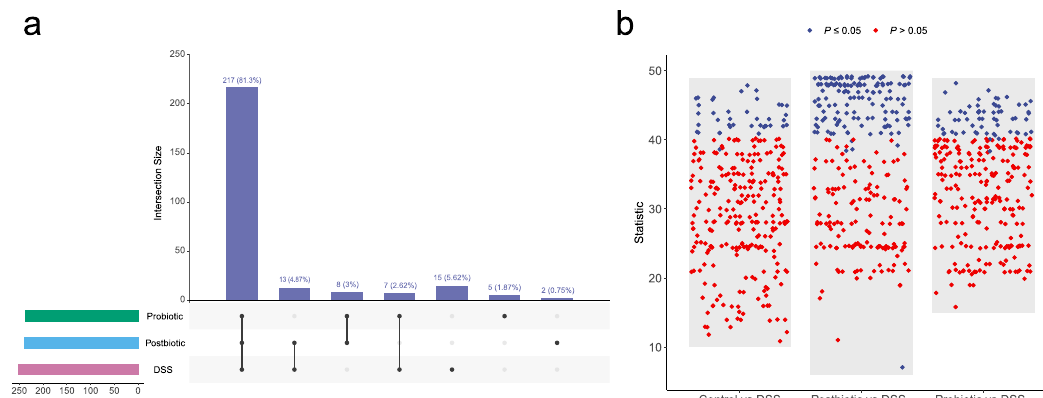
Fig. 5 Postbiotic and probiotic supplementation modulated the functional potential of the gut microbiome. a Number of metabolic pathways identi fi ed in the fecal metagenome of the Postbiotic, Probiotic, and Dextran sulfate sodium (DSS) groups (left panel). The right panel shows common pathways between datasets. b Number of differential metabolic pathways between groups: Control, Postbiotic, Probiotic groups versus DSS group. Differential metabolic pathways were detected by Wilcoxon rank-sum test.